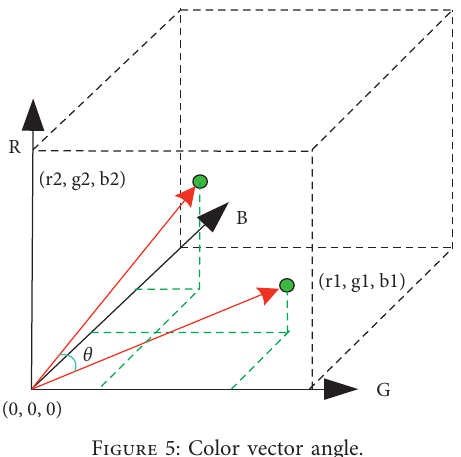
Figure 5: Color vector